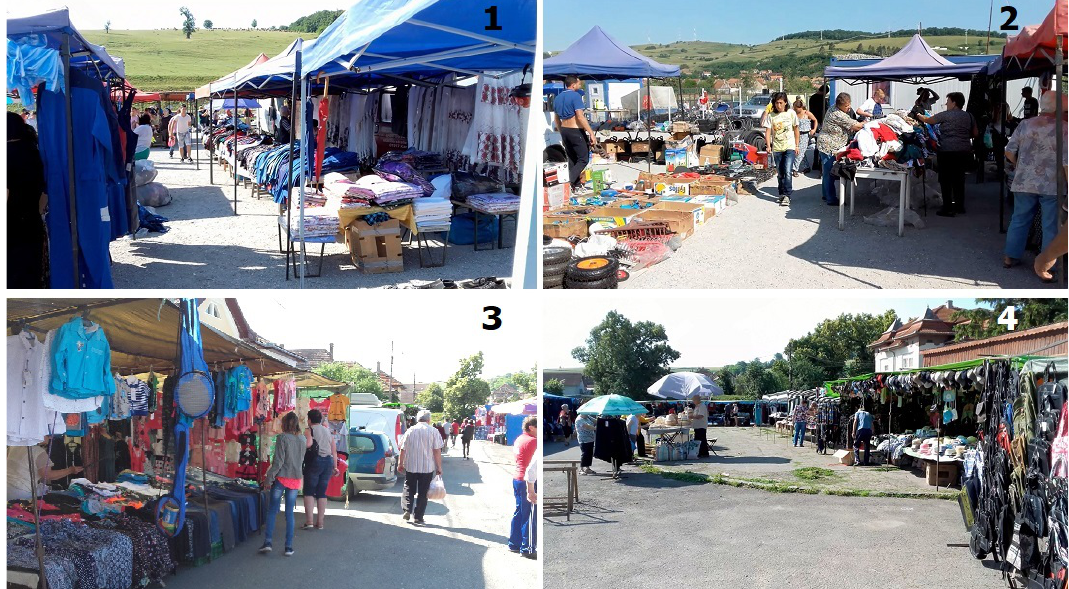
Figure 11: Rupea town’s weekly fair, 1, 2 – the market outside the town, 3, 4 – the old market Photographs by Zoltan MAROȘI,